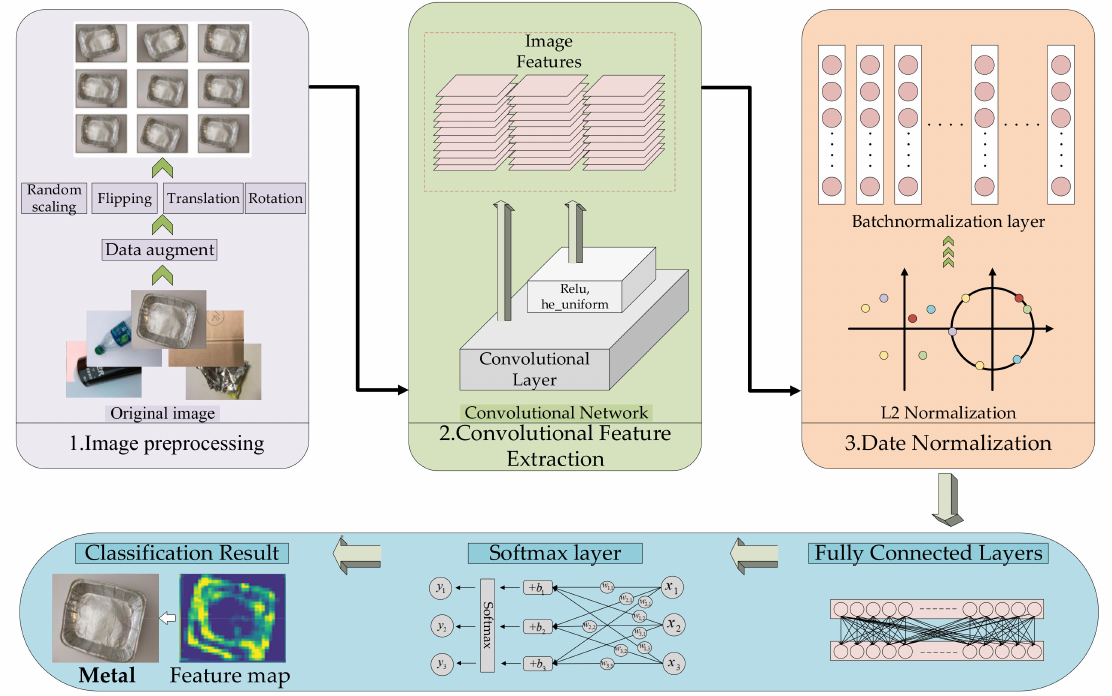
Figure 1. The overall process of the proposed waste classification